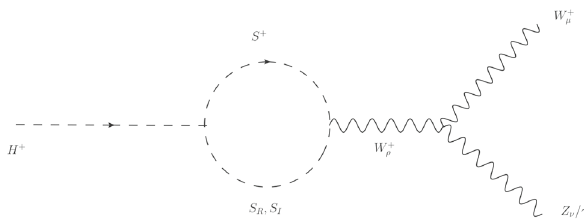
Fig. 2 Set B of one-loop